Question: Which visualization type does this figure use?
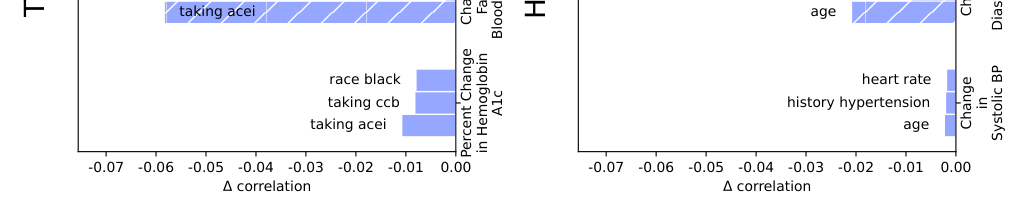
Answer: bar